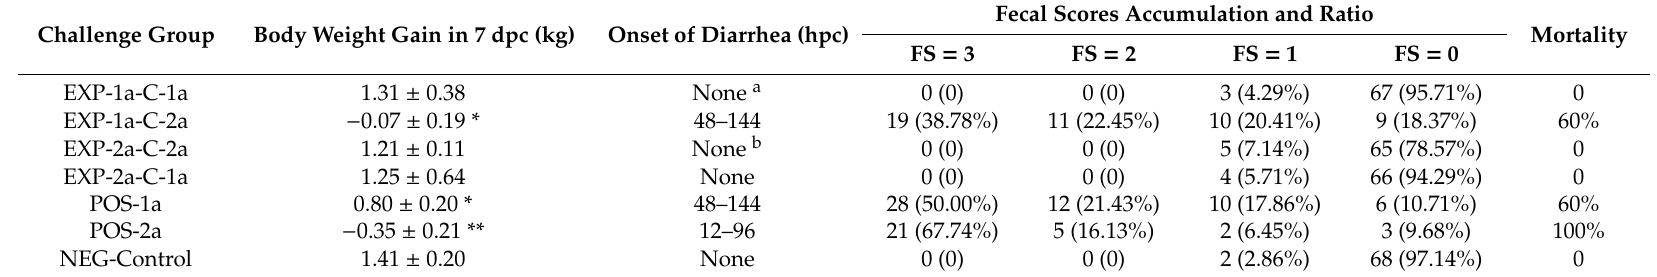
Table 1. Clinical observations of piglets in the first week post challenge.